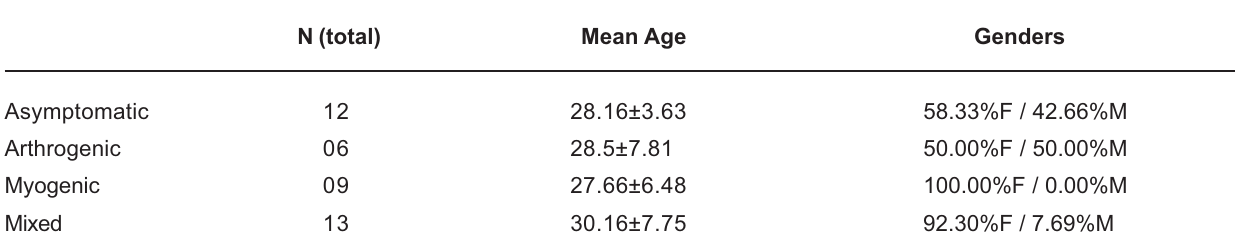
TABLE 1- Characteristics of the evaluated